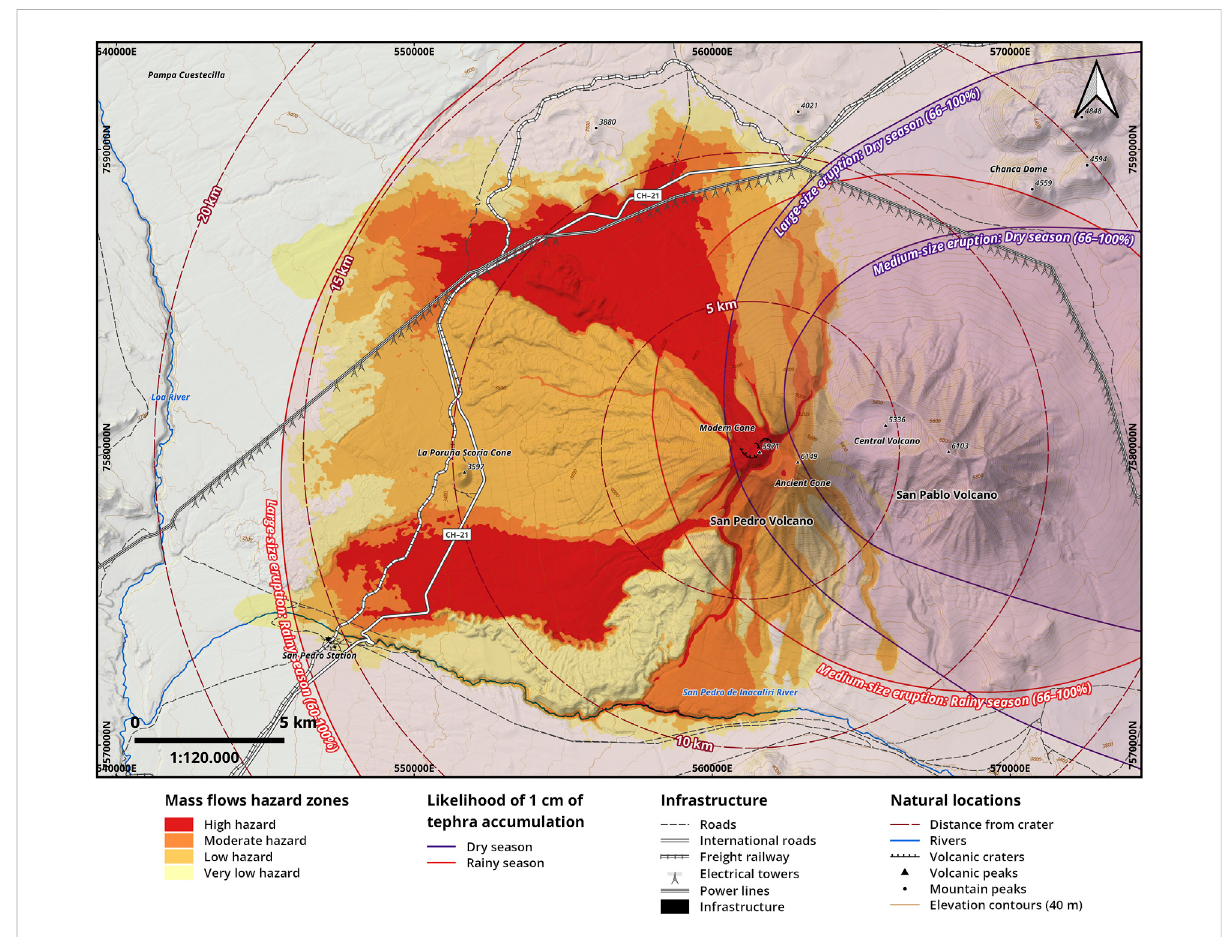
FIGURE 6 Final integrated multi-hazard zone map of tephra fallout and mass fl ows (1:120,000